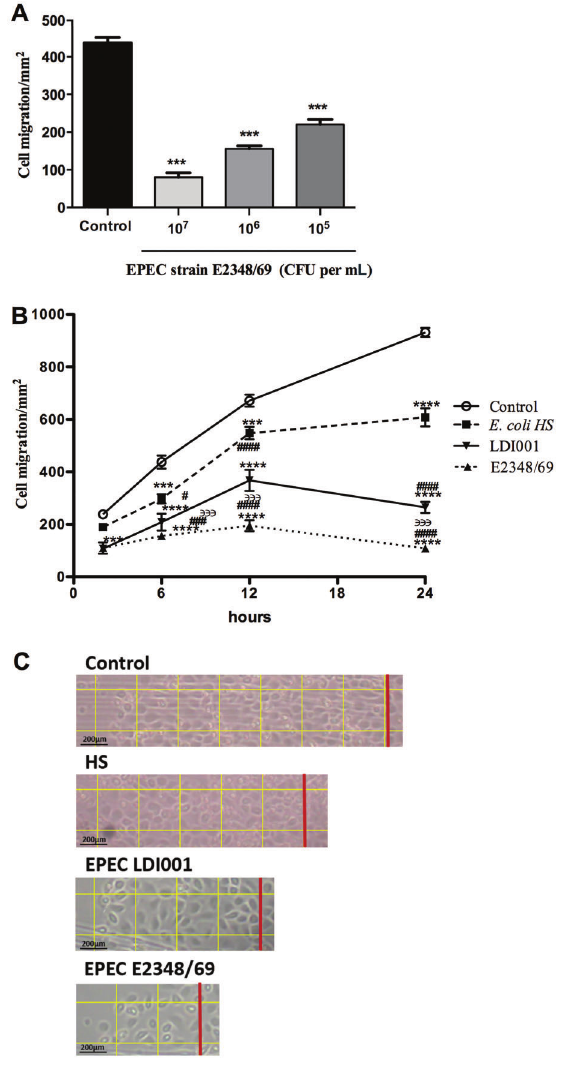
Figure 1 . Effects of bacteria on IEC-6 cell migration. A , Con- centration analysis of enteropathogenic Escherichia coli (EPEC) strain E2348/69 with 10 5 , 10 6 , and 10 7 cell forming units (CFU) per mL on cell migration at 6 h to determine optimum inoculum. B , Time-course analysis of damage on intestinal epithelial cells migration induced by EPEC strain E2348/69 and LDI001, and commensal E. coli strain HS (inoculum, 10 6 CFU per mL). Data are reported as mean ± SE of three independent experiments (n=8). C , Intestinal cell migration after 24 h. The red line represents the initial cut and each square has an area of 0.1 mm 2 . Magni fi cation 10 (cid:1) , bar: 200 m m. ***P o 0.001 and ****P o 0.0001 vs uninfected control; # P o 0.05, ### P o 0.001, and #### P o 0.0001 vs E. coli strain HS; EEE P o 0.001 vs EPEC strain LDI001 (ANOVA followed by Bonferroni ’ s